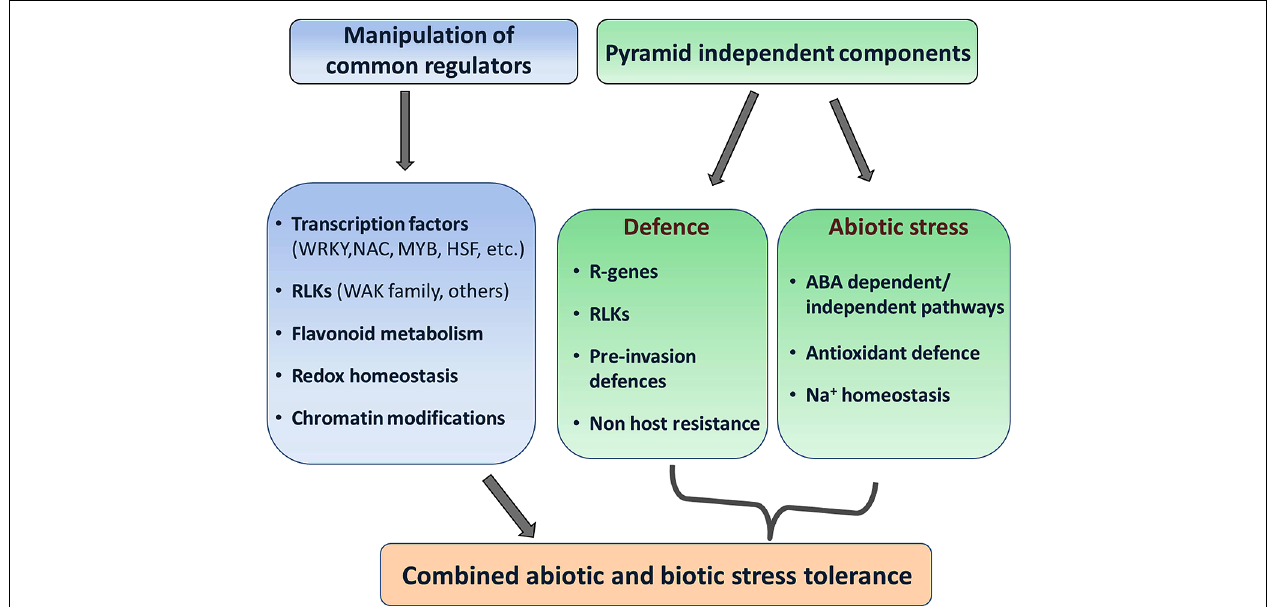
FIGURE 3 |Approaches for building combined abiotic and biotic stress tolerance in plants. Two strategies are proposed through either the manipulation of genetic components which potentially regulate resistance to both stresses in a preferentially unidirectional manner, or the